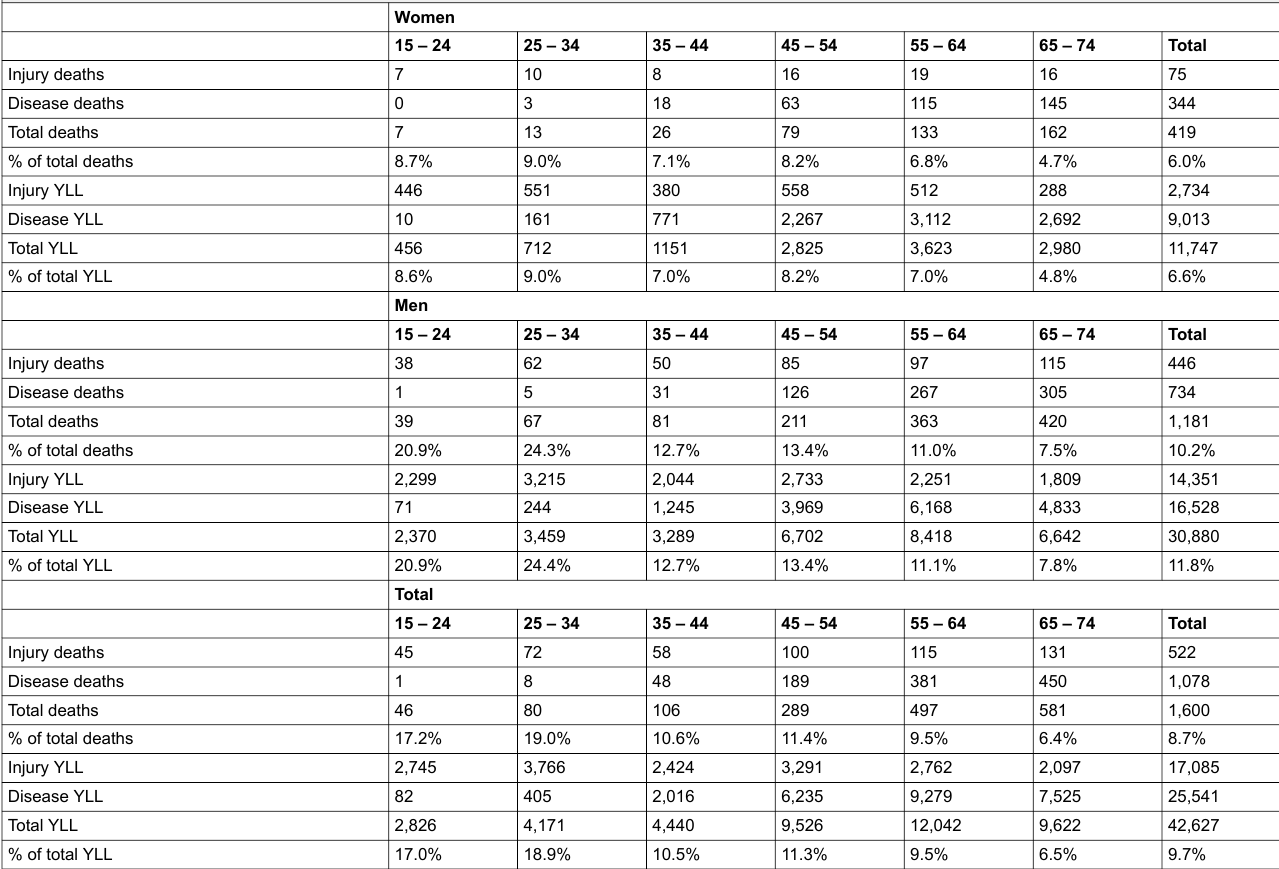
Table 4: Alcohol-attributable deaths and years of life lost (YLL) by age and injuries versus